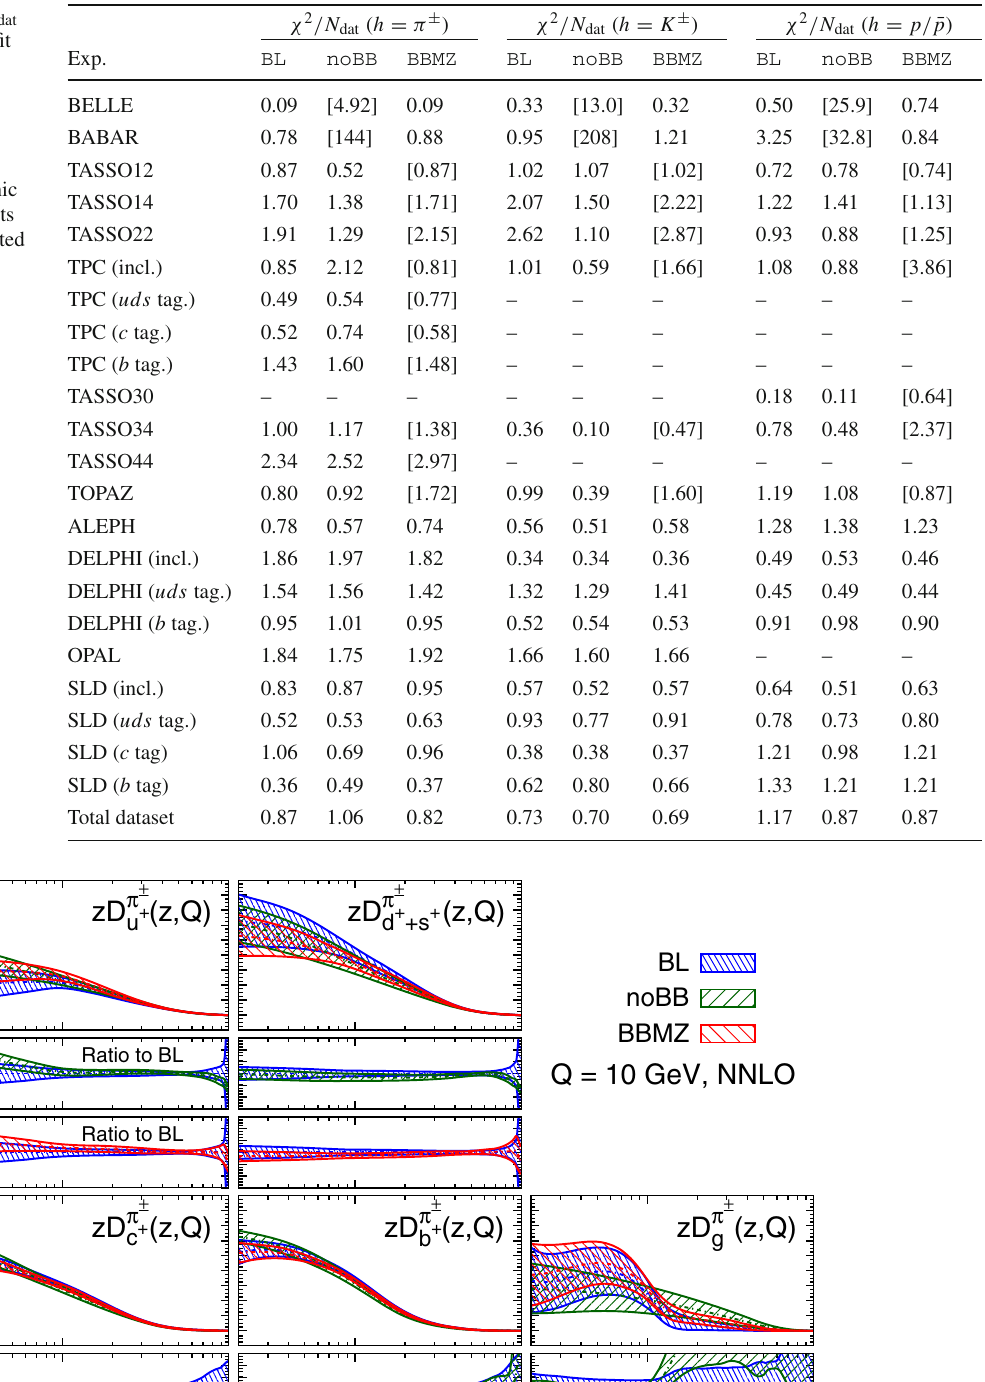
Table 5 The values of χ 2 / N dat for the baseline ( BL ) NNLO fit and for the fits with dataset variations, noBB (excluding BELLE and BABAR), and BBMZ (including only B -factories, LEP and SLD experiments), for each hadronic species. The values for datasets not included in a fit are indicated in squared brackets